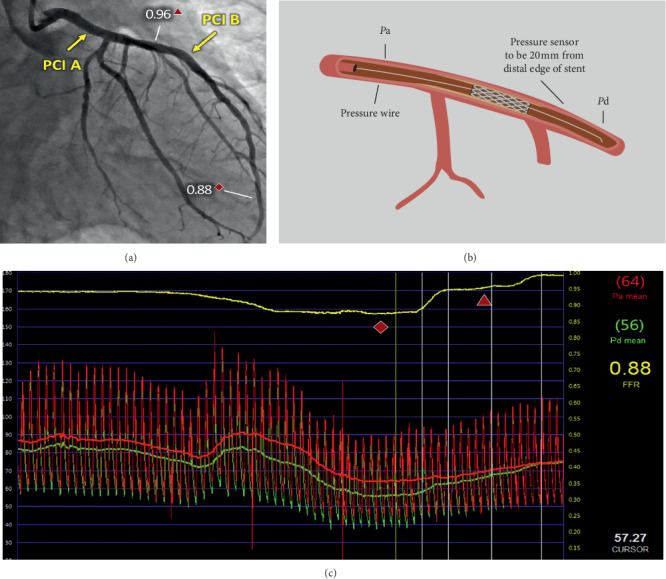
(a) Angiographic image of post-PCI FFR in the distal left main stem and mid-left anterior descending artery (b) Conceptual representation of post-PCI pressure measurements. FFR is calculated as a ratio of distal coronary pressure (Pd) to aortic pressure (Pa). FFR = Pd/Pa. (c) Pressure curve from post-PCI FFR measurement in the patient from part A, displaying pressure drops across the two stents. (a) and (c) are adapted from Ihdayhid et al. [30] with permission. Copyright © 2016, Elsevier.